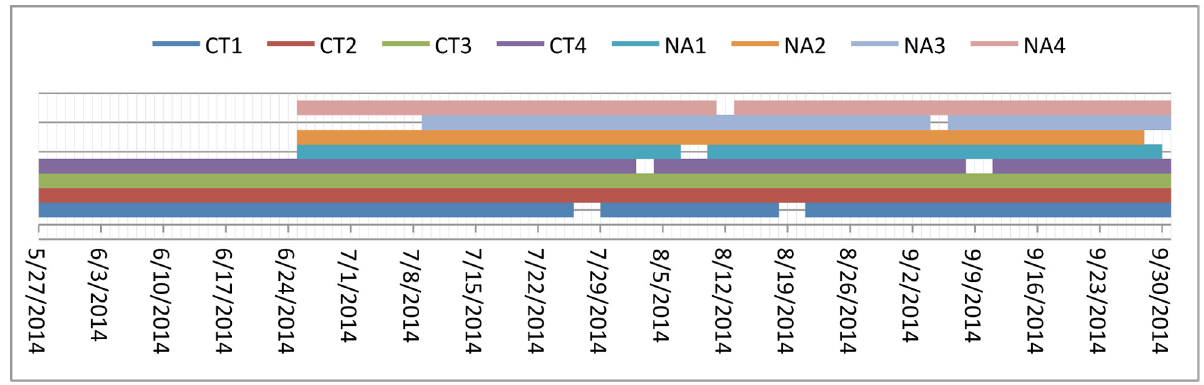
Table 1. Working status of the array stations during the period under investigation. Date format: d/m/yyyy.